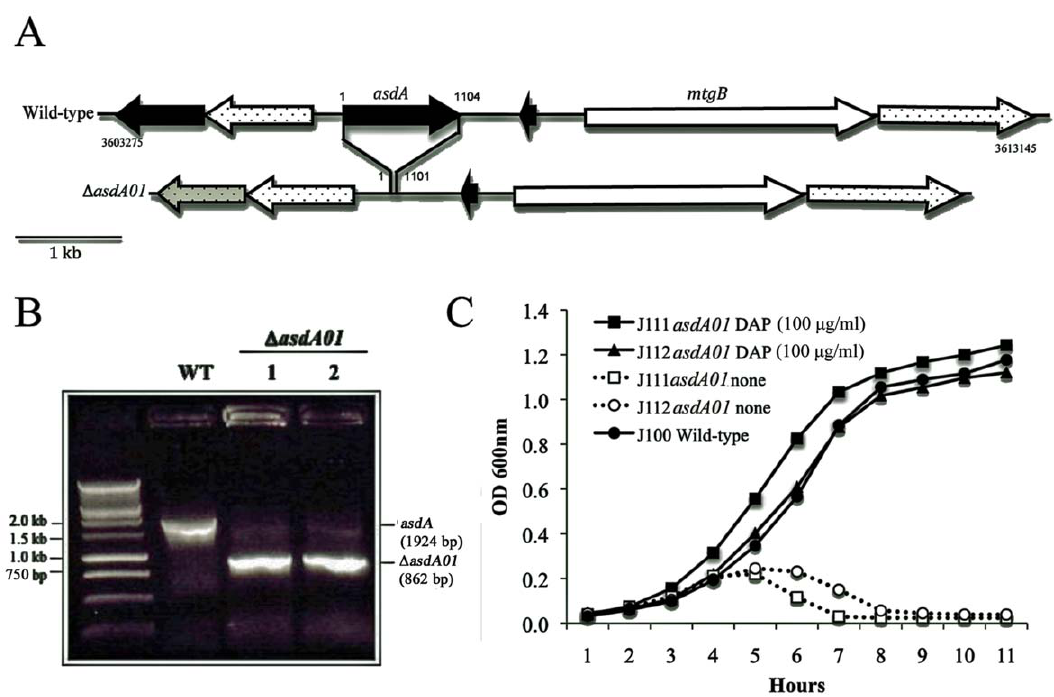
Figure 4. Deletion of asdA gene in E.ictaluri . A. Deletion map of D asdA01 ; B. Genotype verification of J112 D asdA01 by PCR; C. Phenotype of E. ictaluri J111 D asdA01 and J112 D asdA01 mutants. The strains were grown in BHI at 28 u C with agitation (180